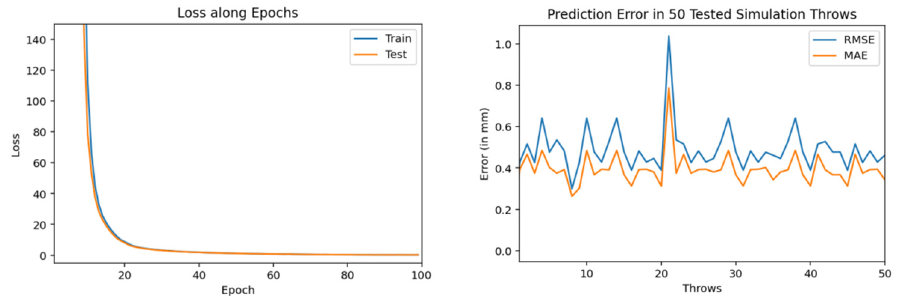
Figure 10. Training and testing results by encoder-decoder bidirectional LSTM deep NN (trained through 200 throws with 100 epochs and 100 neurons).